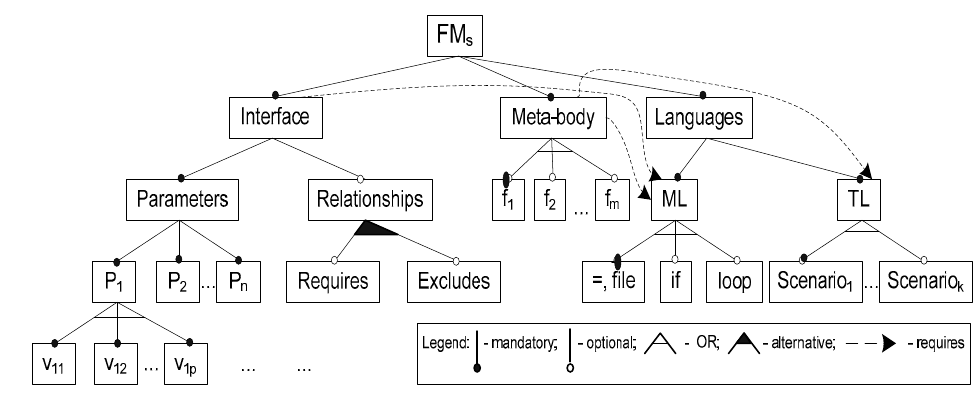
Figure 3. The solution domain feature model with abstract variants (shortly FMs).